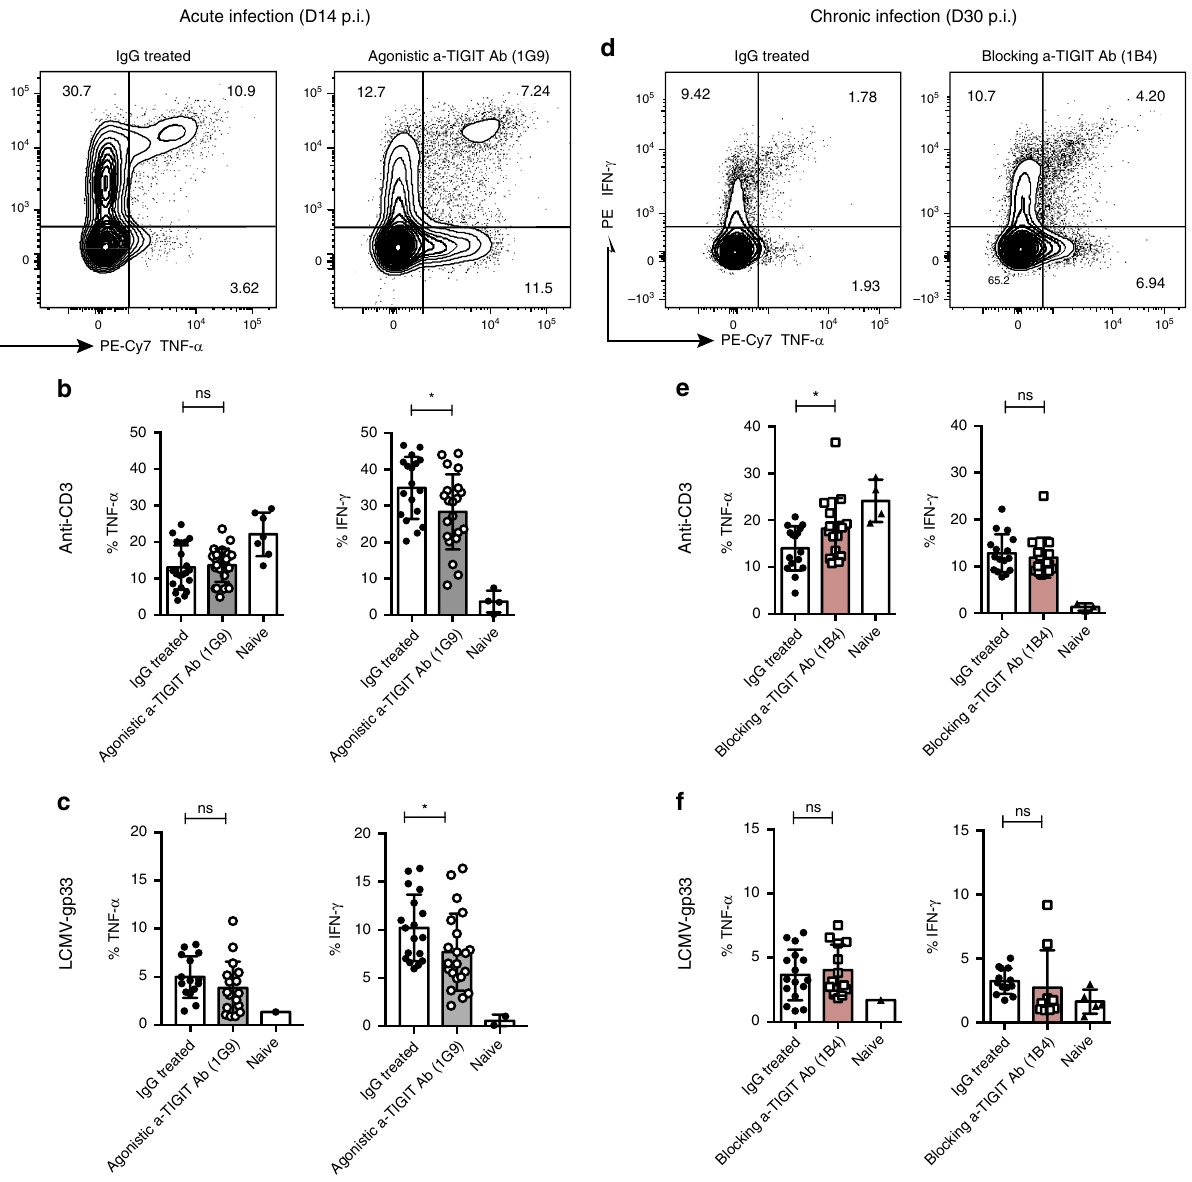
Fig. 4 TIGIT ligation results in decreased pro-in fl ammatory cytokine production after acute infection. C57BL/6 mice were infected with either 2 × 10 6 FFU LCMV clone 13 i.v. (red) or 1 × 10 5 FFU LCMV clone 13 i.v. (gray). Chronically infected mice (red) were treated with 100 μ g of blocking anti-TIGIT (1B4) Ab or mouse IgG1 i.p., acutely infected mice (gray) were treated with 100 μ g of agonistic anti-TIGIT (1G9) Ab or mouse IgG1 i.p. a , d Representative FACS plots displaying pro-in fl ammatory cytokine expression of splenic CD8 + T cells after acute infection (gray) and chronic infection (red) ( b ) on day 14 p.i. with acute LCMV clone 13. FACS-based quanti fi cation of pro-in fl ammatory cytokine production by splenic CD8 + T cells after anti-CD3 re-stimulation ( n = 18 – 22) ( c ) on day 14 p.i. after gp33 re-stimulation ( n = 13 – 20). FACS-based quanti fi cation of pro-in fl ammatory cytokine production by splenic CD8 + T cells after ( e ) after anti-CD3 re-stimulation ( n = 15 – 25) ( f ) after gp33 re-stimulation ( n = 9 – 16). Each symbol in the scatter plot represents an individual mouse, and bar graphs indicate the mean value ± SD. Statistical values p < 0.05 (*), p < 0.01 (**), p < 0.005 (***), or ns (not signi fi cant, p > 0.05) determined by Student ’ s t